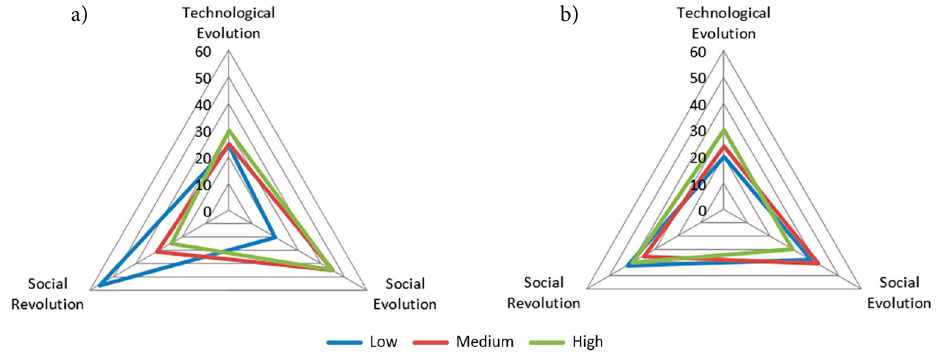
Figure 3. Students’ expectations in relation to knowledge (a) and usage (b)